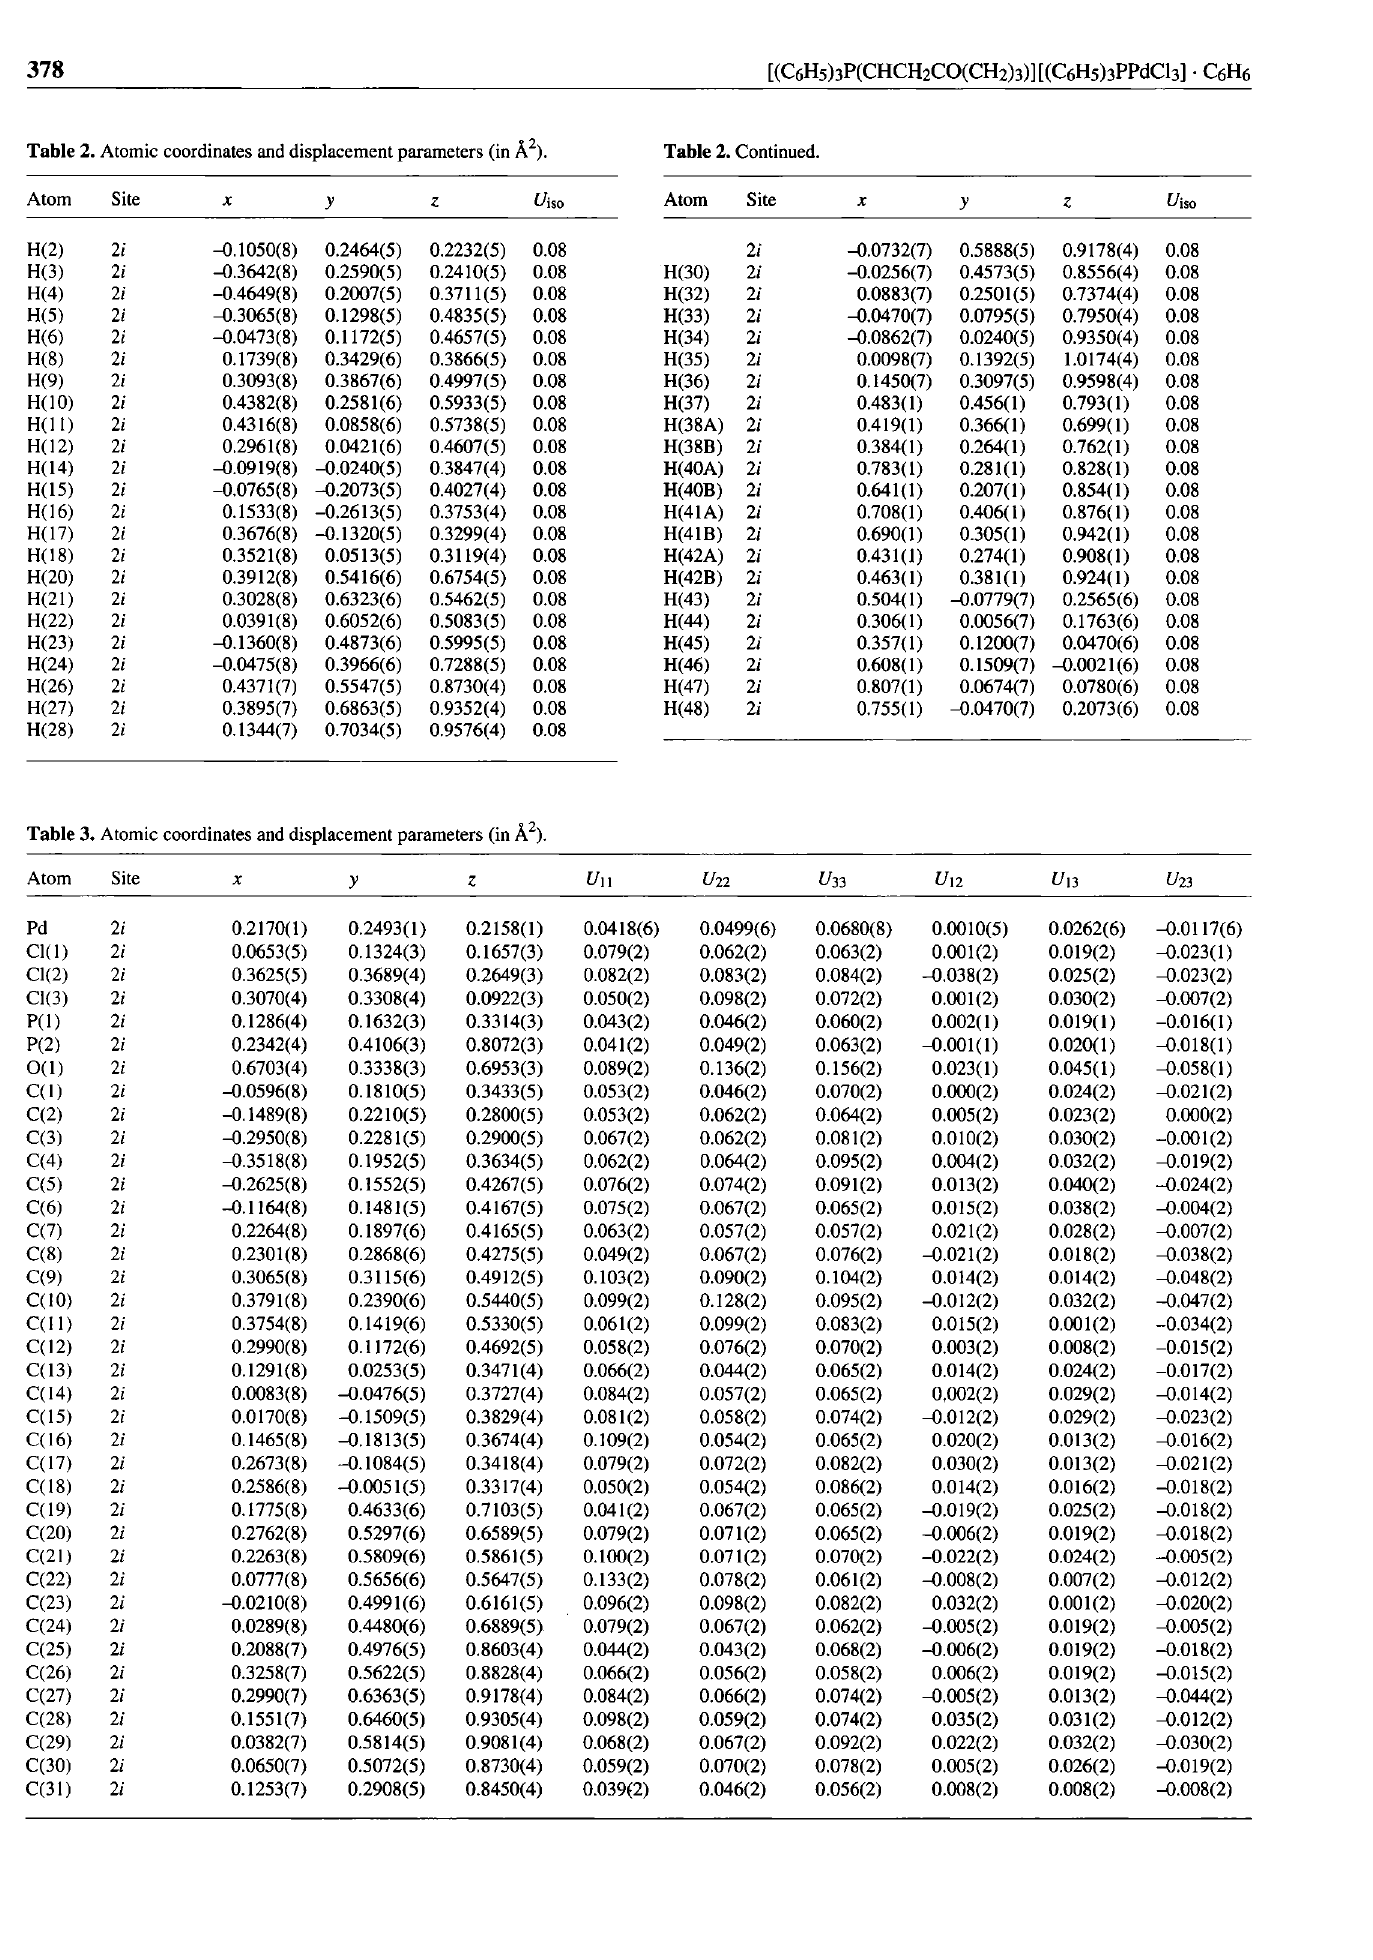
Table 2. Atomic coordinates and displacement parameters (in Ä 2 ). Table 2. Continued.